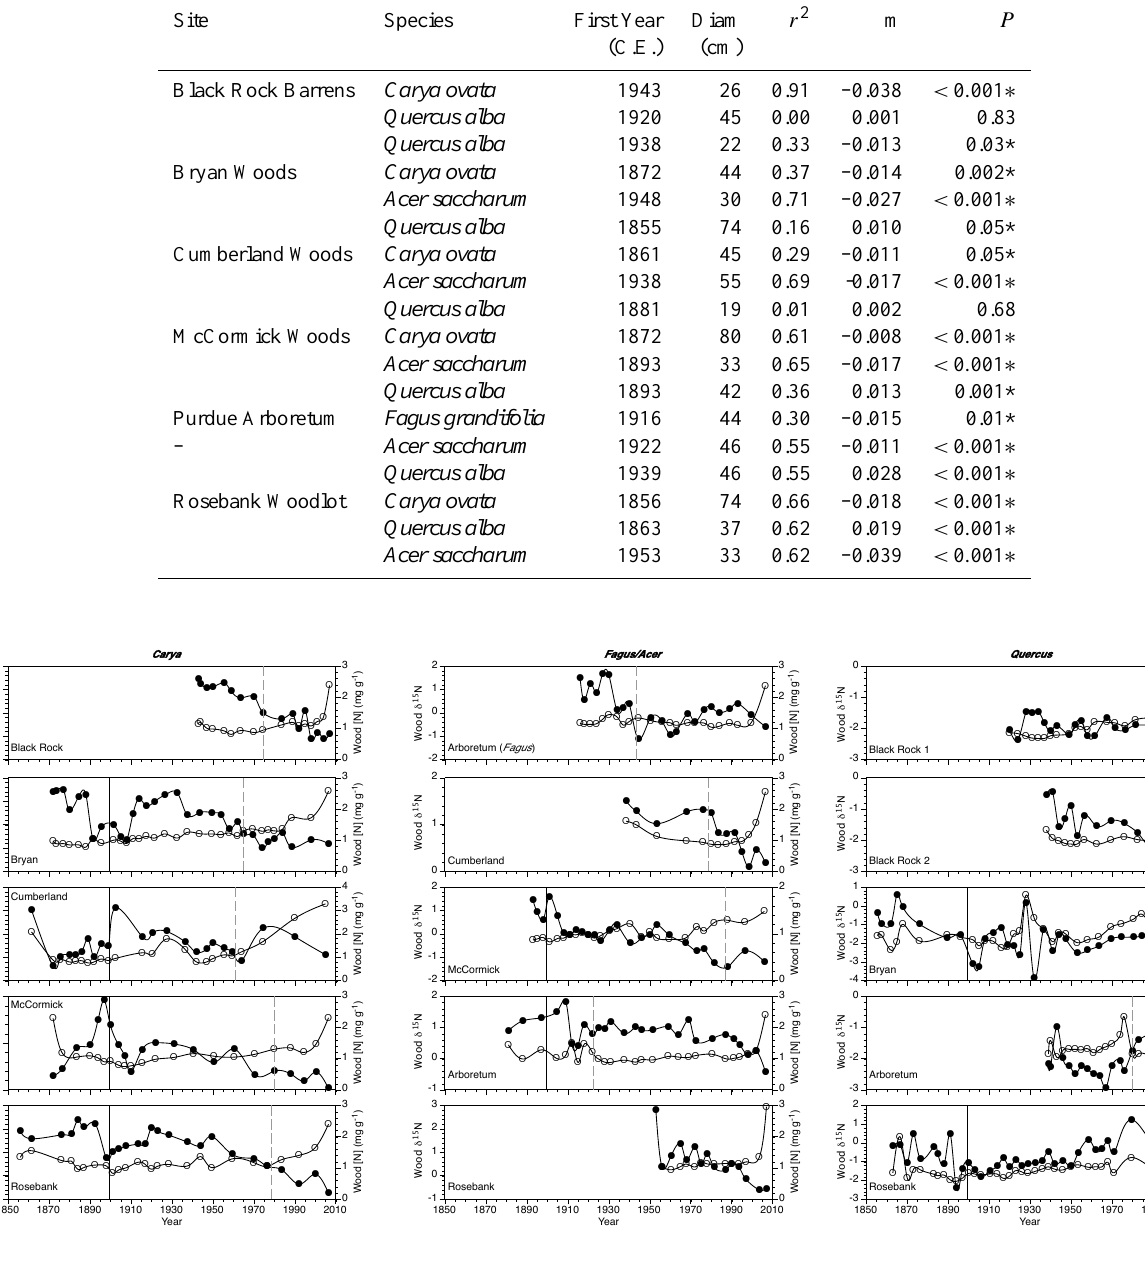
Fig. 4. Nitrogen characteristics of wood samples from each individual tree sampled. For each increment core, solid circles indicate wood δ 15 N, open circles are wood [N], the solid line is 1900 C.E. and the dashed line is the heartwood-sapwood